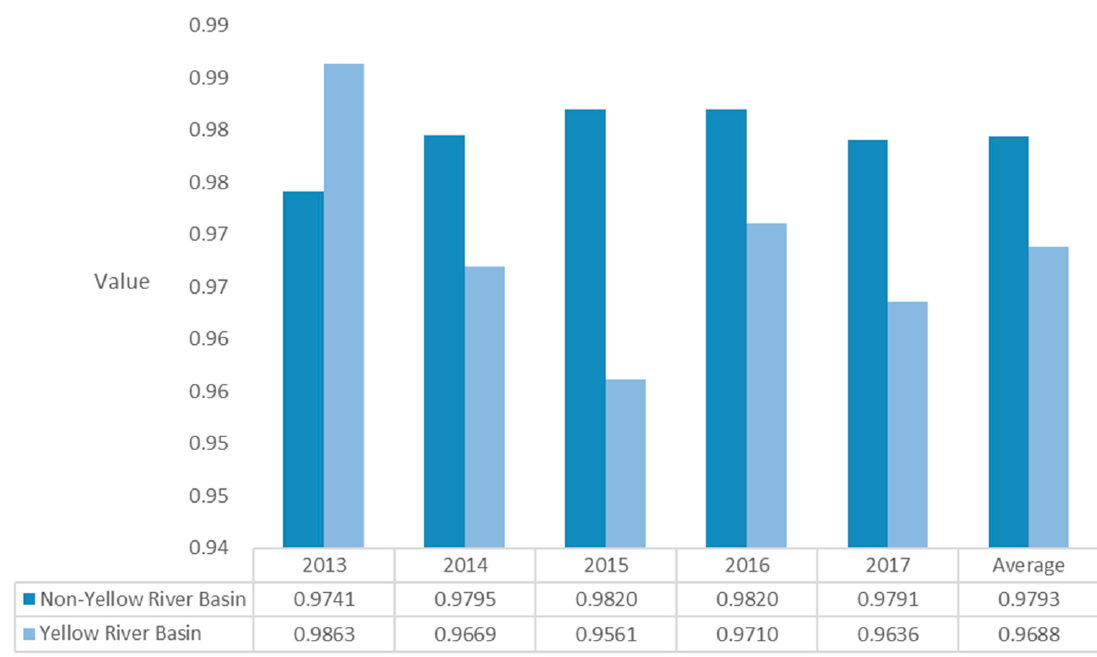
Figure 4. Efficiency of DDF in the Yellow River and Non-Yellow River Basins from 2013 to 2017. (2) interval is 95%, and the result shows that z = − 3.517, which indicates that there are regional differences in DDF efficiency between the Yellow River Basin and the Non-Yellow River Basin, and the efficiency value of the Non-Yellow River Basin is better than that of the Yellow River